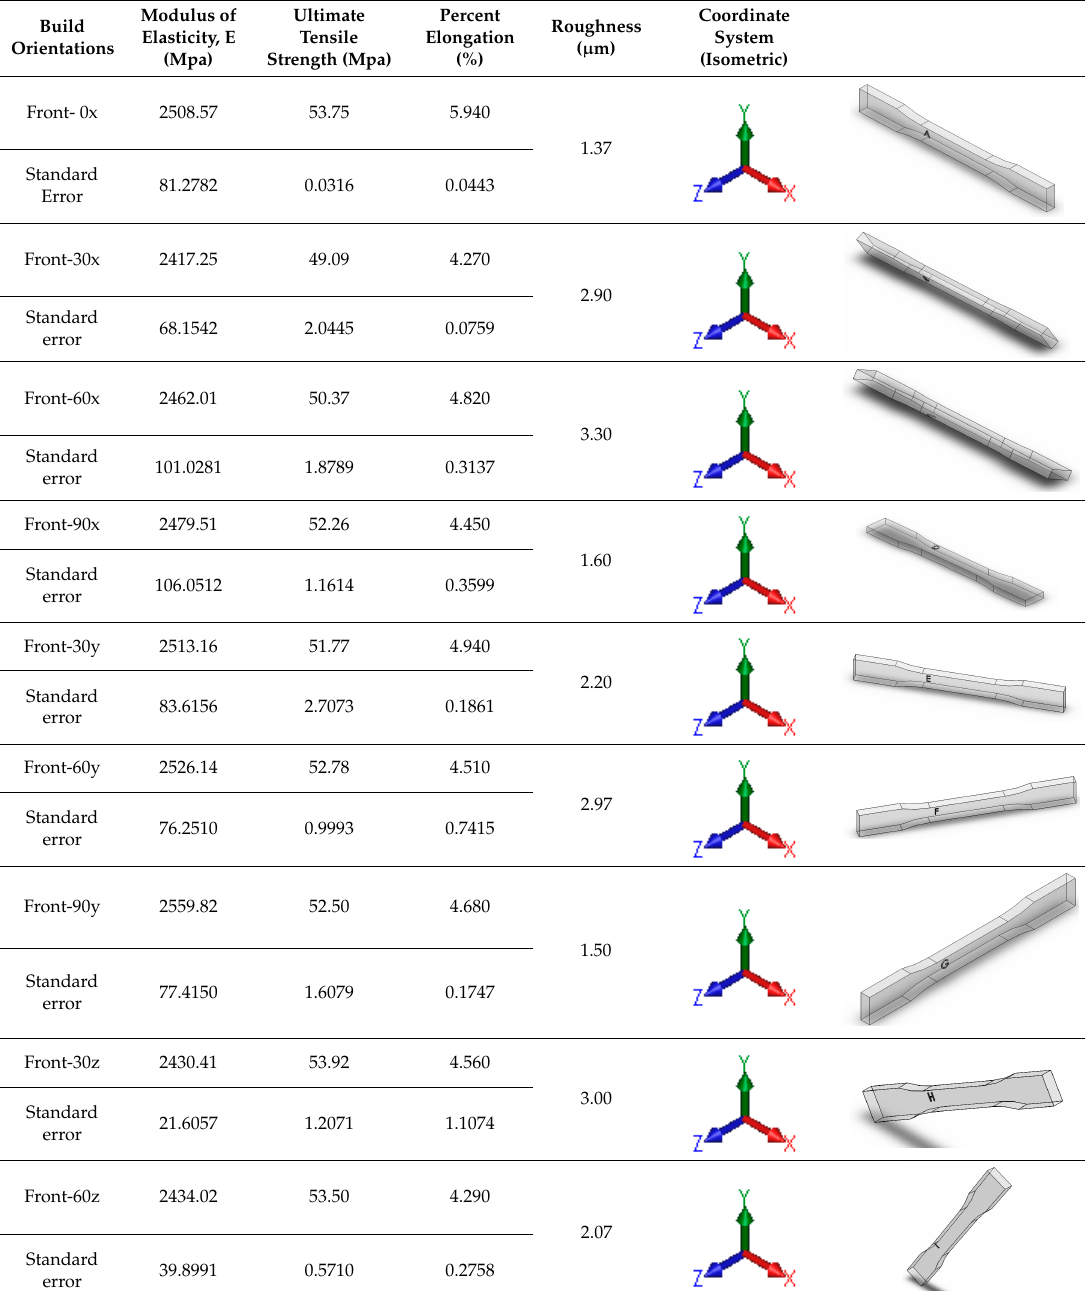
Figure 9. The mean surface roughness for the different orientations. Table 2. Tensile test average results and mean surface roughness for all unique configurations.